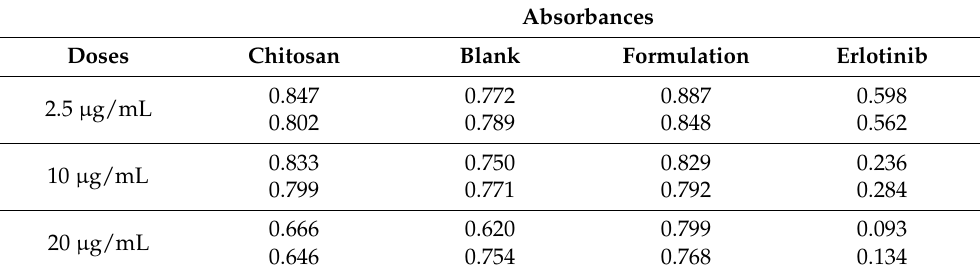
Table A1. Absorbances to be evaluated.